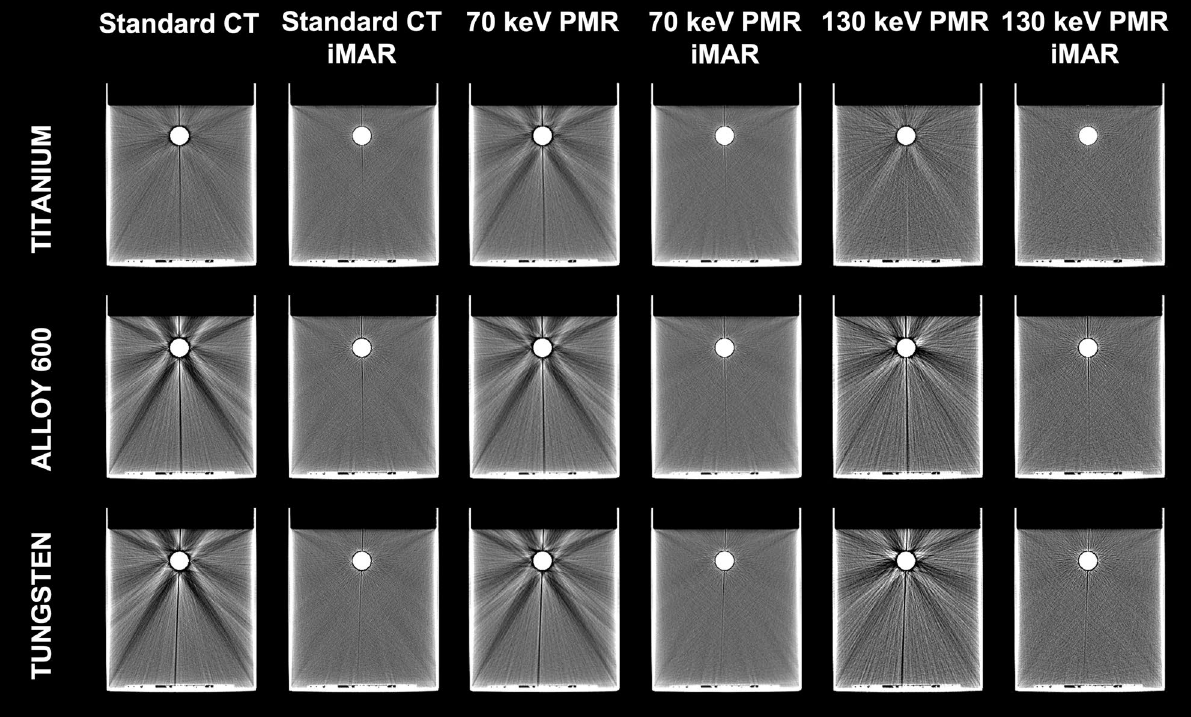
Figure 2. CT images of the phantom with titanium, alloy 600, and tungsten inserts obtained using a range of reconstruction modes. PMR pseudo-monoenergetic reconstruction, iMAR iterative metal artefact